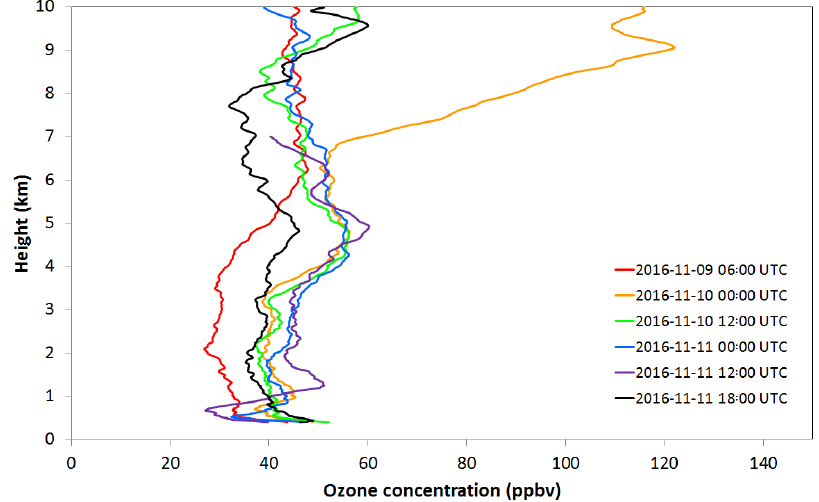
Figure 10. A plot showing ozone profiles between 9 and 11 November as the ozone-rich stratospheric air descends down into the troposphere.